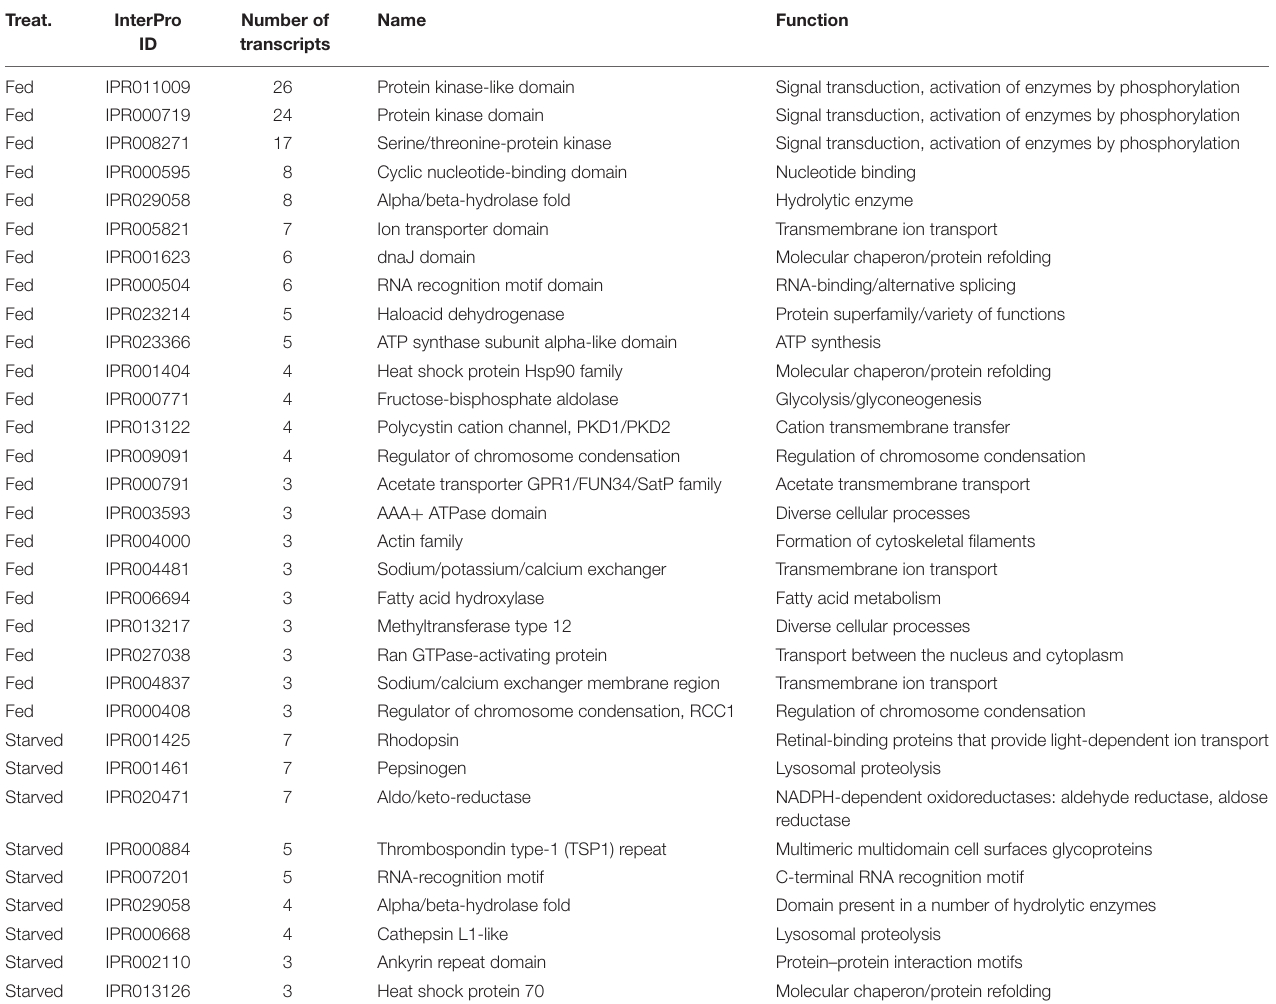
TABLE 5 | Most frequent protein domains found among significantly differentially expressed transcripts from RNA-Seq analysis of O. marina cells in culture conditions with (fed) and without (starved) different phytoplankton prey types.